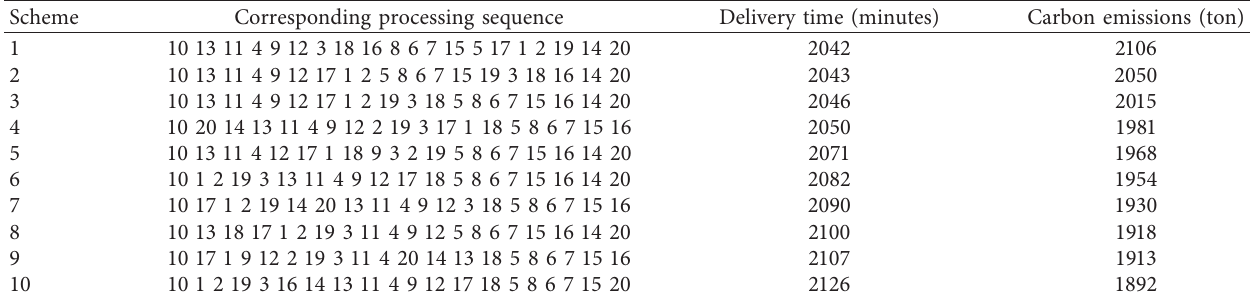
Table 2: Multiobjective decision-making